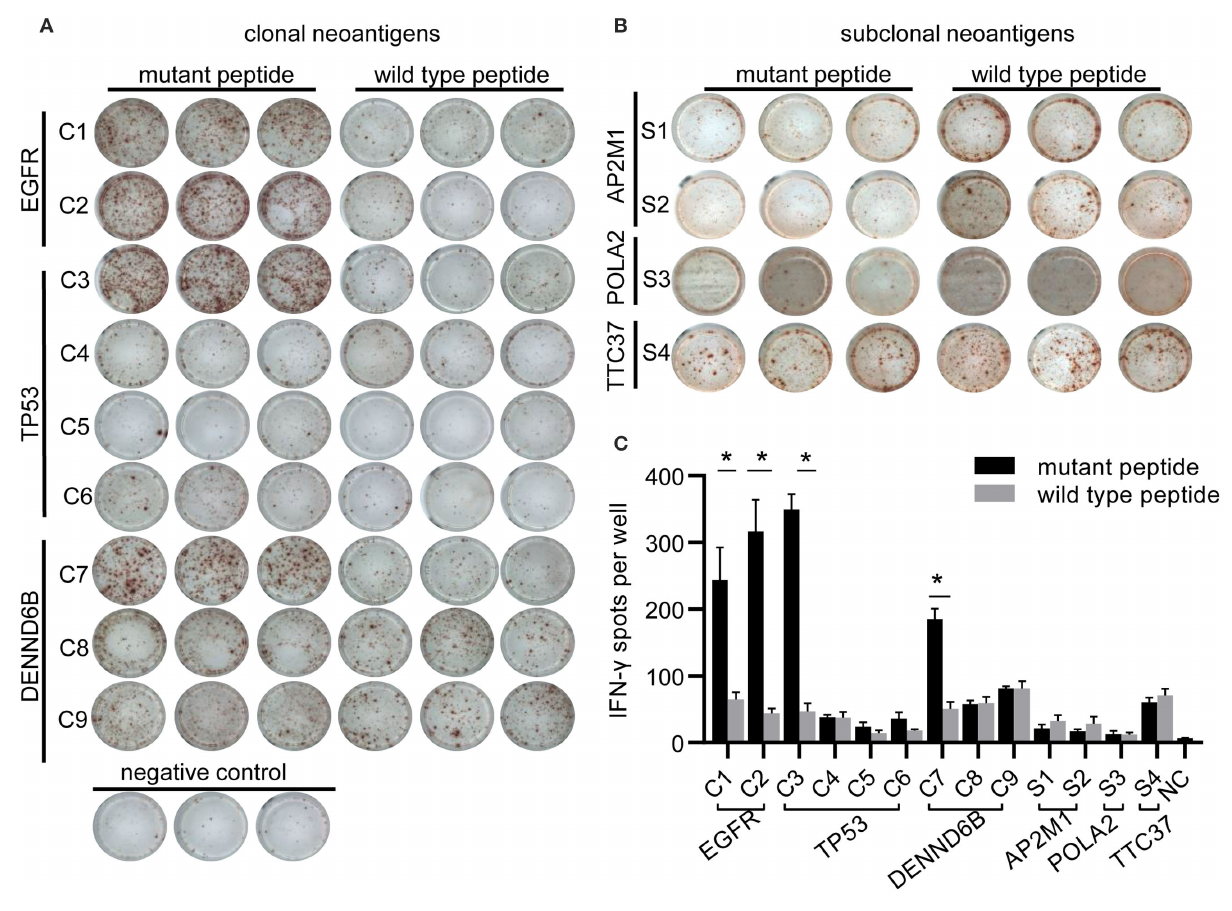
FIGURE 3 | Immunogenicity of candidate neoantigens. (A,B) Representative images from IFN- γ ELISPOT assay. Peripheral blood mononuclear cells (PBMCs; 2 × 10 5 per well) from the patient were stimulated for 10 days with individual peptides in the presence of cytokines (IL-2, IL-7, and IL-15) and were stimulated again on day 10. T-cell reactivity was assessed by IFN- γ ELISPOT assay. (C) Bar graph showing IFN- γ ELISPOT assay data. PBMCs stimulated with no peptide were regarded as negative controls (NC). At least two independent experiments were done in triplicate. * p <